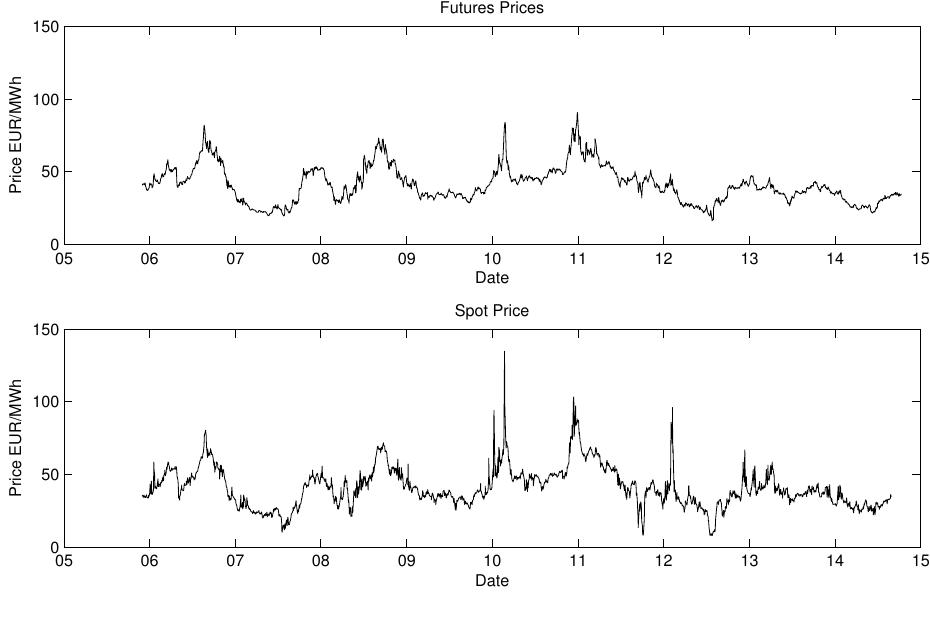
Figure 1. One-month futures and spot prices.